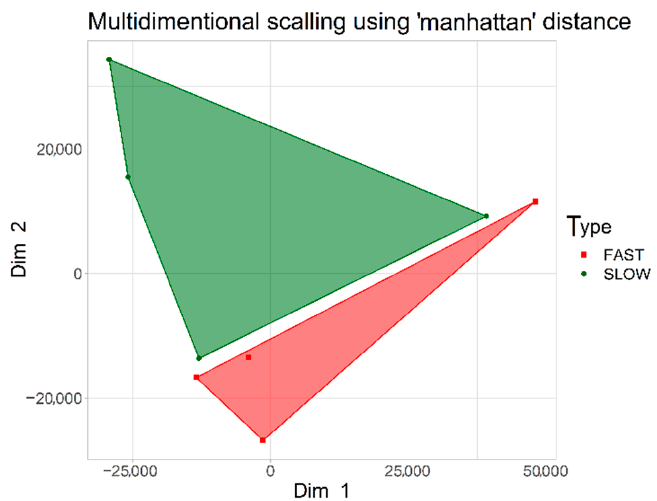
Figure 1. Visualization of MDS analysis using the “Manhattan” method of distance calculation. Two analyzed cohorts are shown: fast-growing salivary gland tumors (red) and slow-growing salivary gland tumors (green).